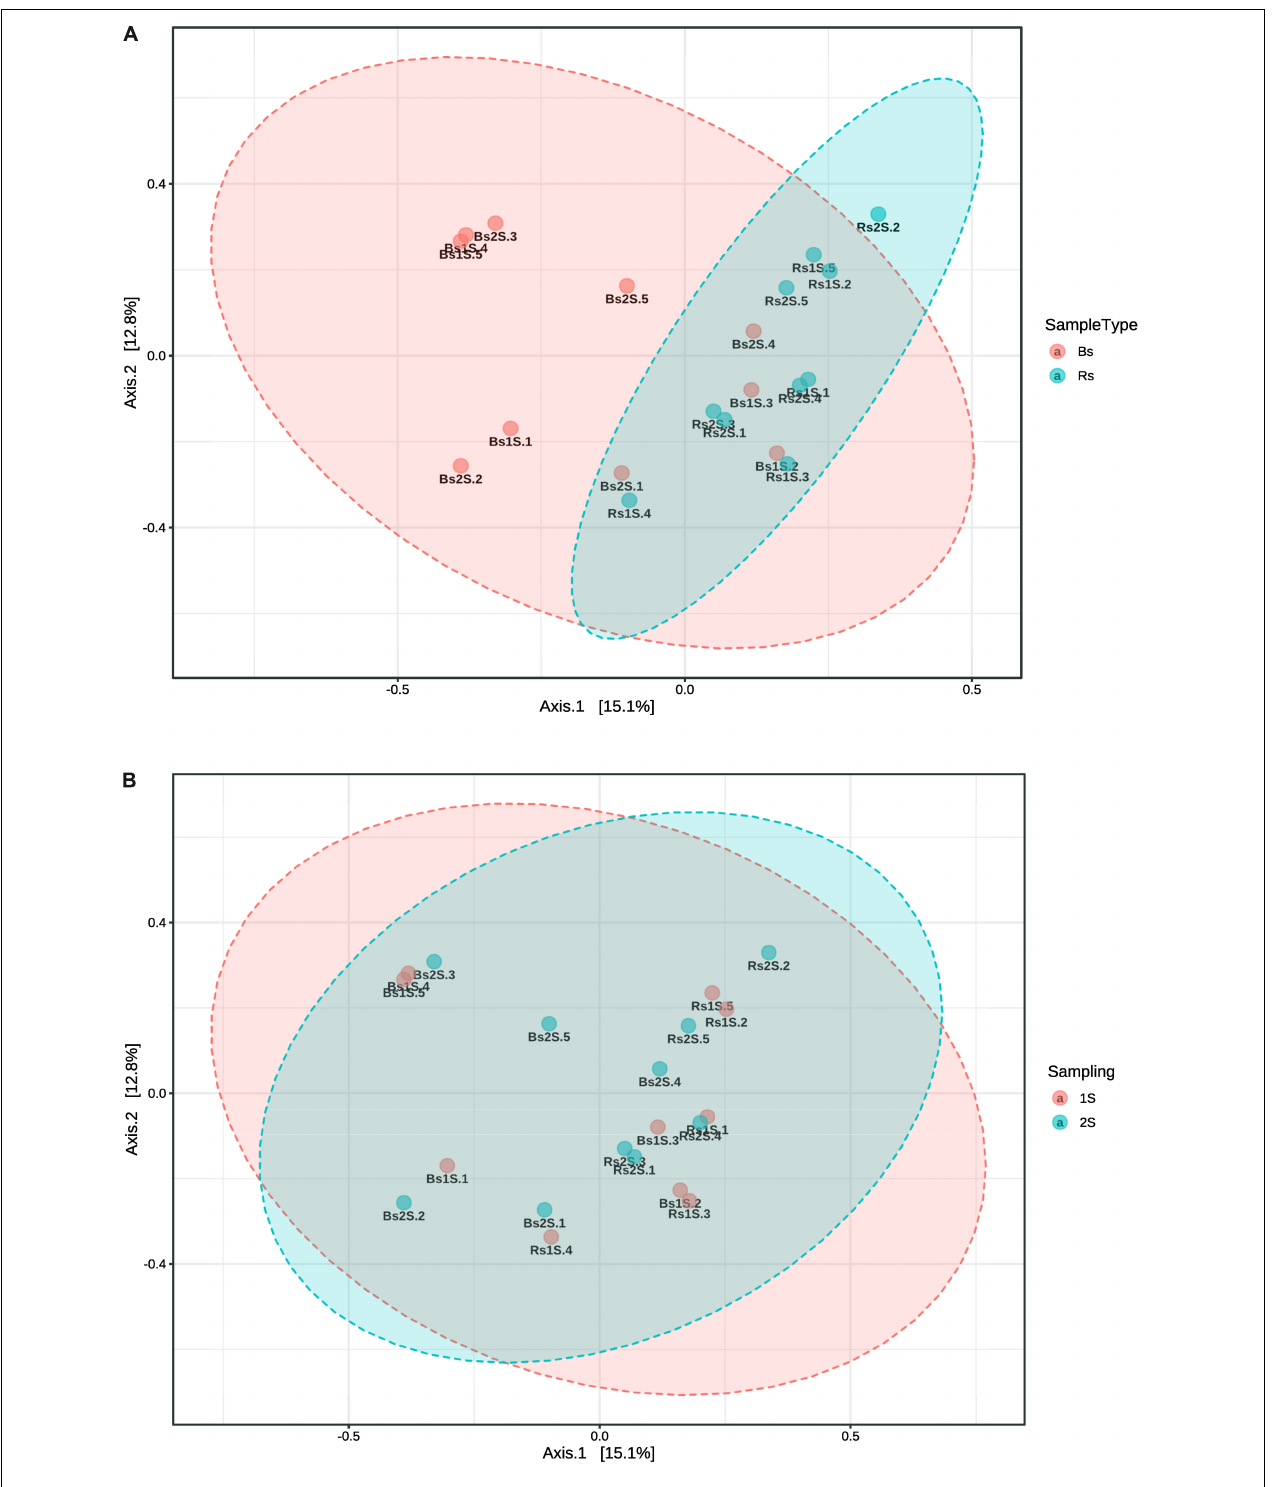
FIGURE 6 | Comparison by principal coordinate analysis of the ecological distance (based on Bray–Curtis distance method) of the different compartments. (A) Soil effect (Bs = soil not associated to grapevine roots, Rs = soil associated with the roots of Vitis vinifera cv. Pinot Noir); PERMANOVA F -value: 1.787, R -square: 0.090312, and p -value < 0.005. (B) Sampling time effect (1S = flowering and 2S = fruit development); PERMANOVA F -value: 0.48119, R -square: 0.026037, and p -value < 0.994. Beta diversity analysis was performed using the phyloseq package of MicrobiomeAnalyst, a freely available online software